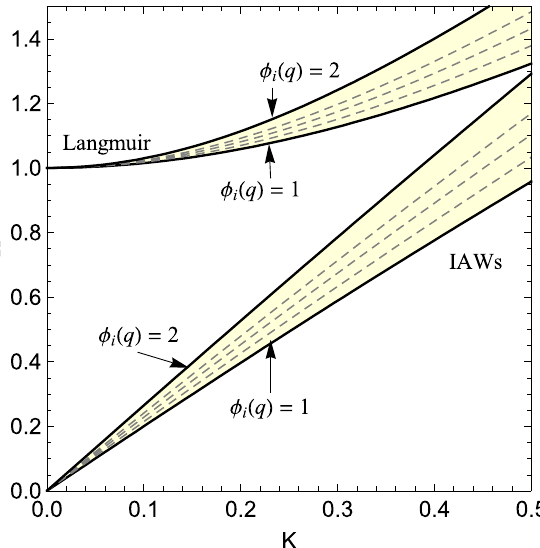
Figure 4. Brillouin diagrams corresponding to the generic DRs for Languir modes [Eq. (25)] and IAWs [Eq. (32)], for different values of the auxiliary function φ i ( q ) . The corresponding degree of inhomogeneities, i.e., β 2 /β 2 0 , can be obtained, for each class of superstatistics, by inverting Eq. q := � �